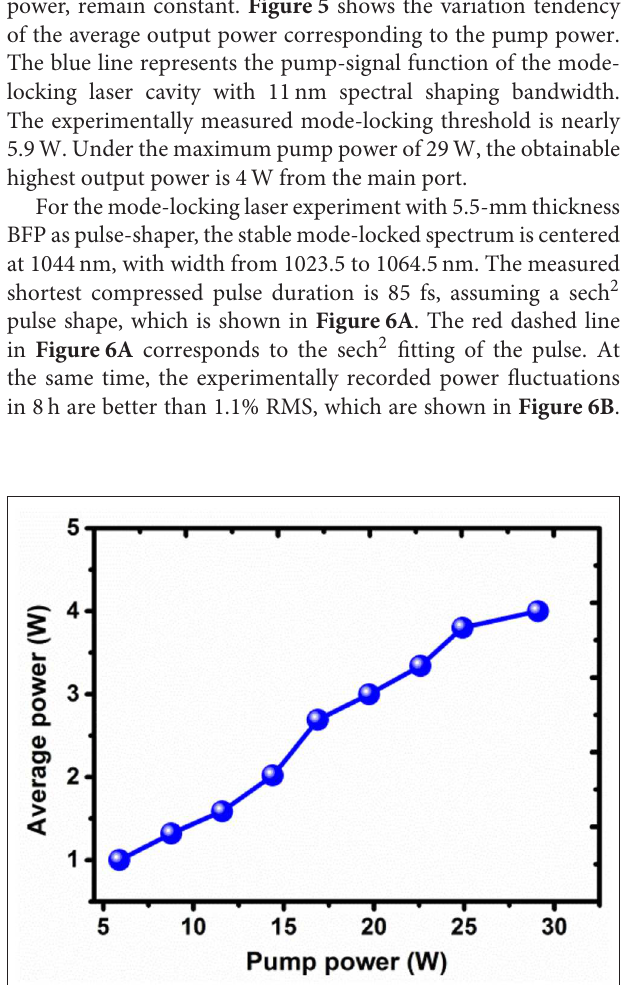
FIGURE 4 | Measured power fluctuations over 8h under the maximum output power of 4.5W with sampling rates of 15 per second. The inset represents the beam profile of the generated dissipative soliton and implies the excellent single-mode beam quality.